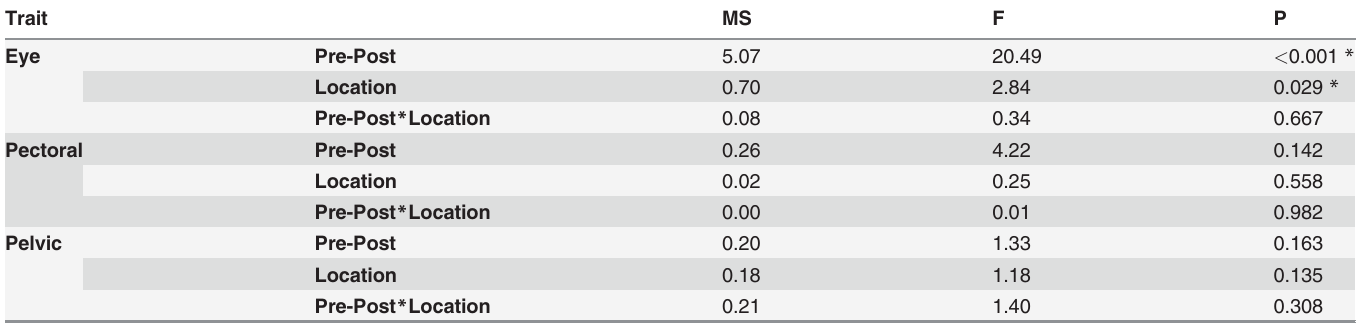
Signi fi cance of F values assessed by maximum likelihood ratio test of nested models (see text for